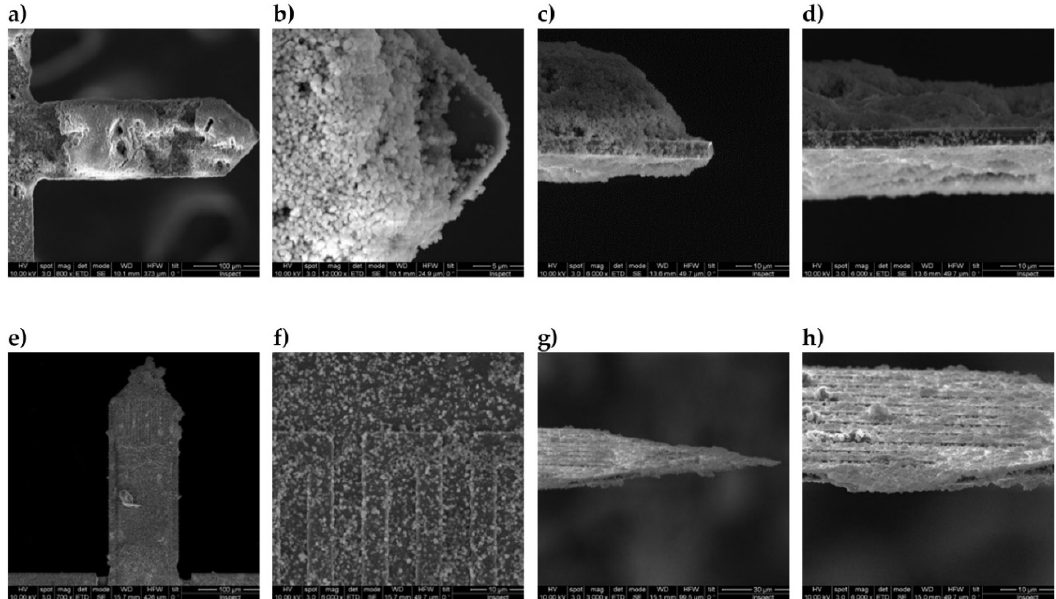
Figure 8. SEM images of microporous silicalite coating on the top of the microcantilever obtained by self-assembly of CBV100 crystals (2% wt. aqueous suspension) onto plasma activated surfaces ( a – d ) and onto poly-(diallyldimethylammonium chloride) (PDDA) activated surfaces ( e – h ) (cantilever #181).